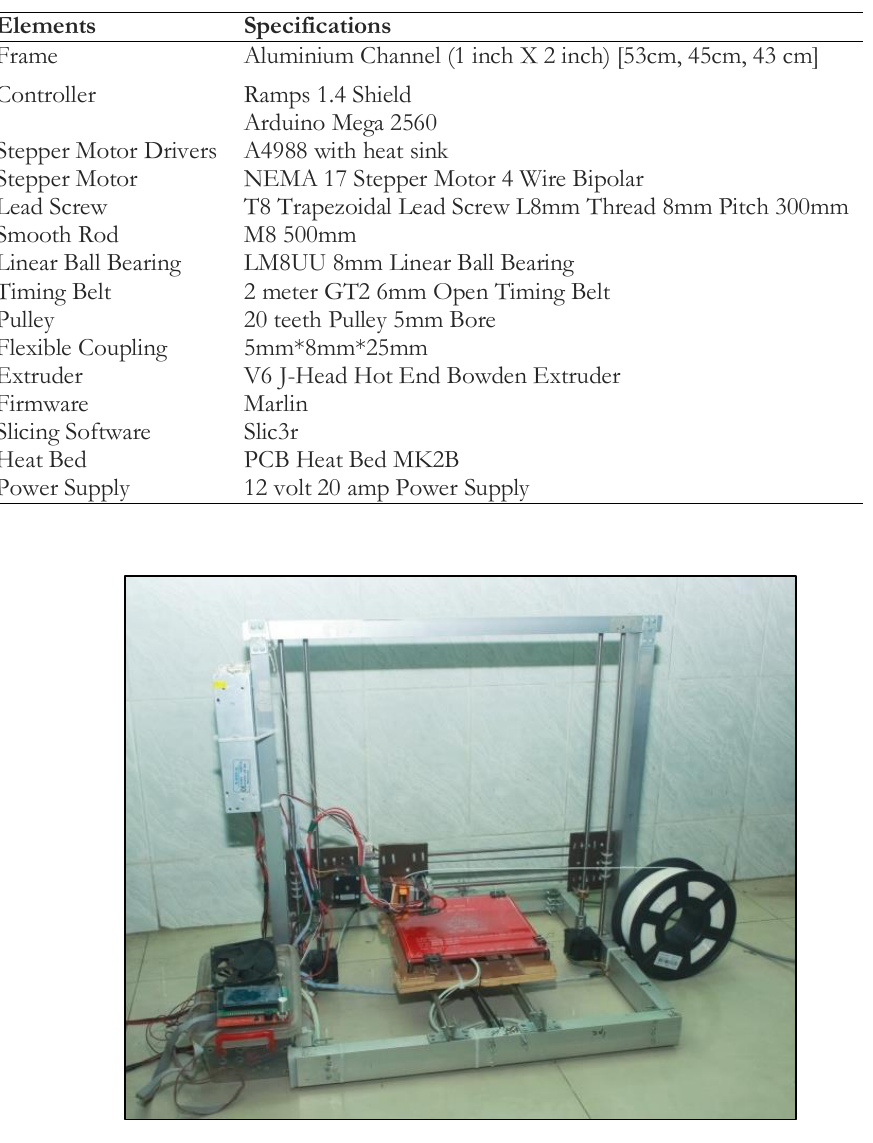
Fig. 1. Final assembly of 3D